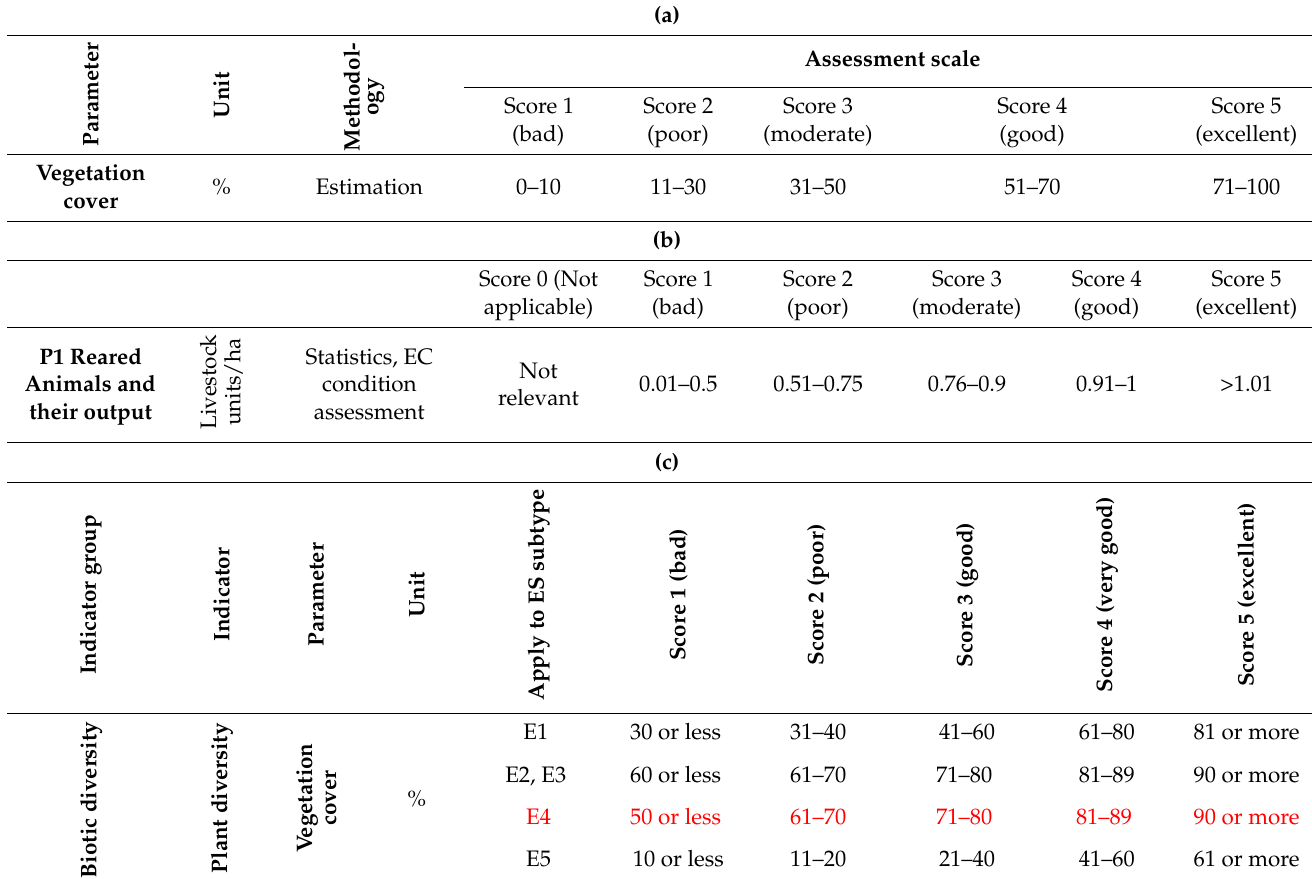
Table 1. Example of cross-ecosystem compatibility of parameter assessments—( a ) assessment scale for a grassland condition parameter; ( b ) assessment scale for grassland ecosystem services; and ( c ) adjustment of reference values for the same parameter after field verification with reference values determined by ecosystem subtype (red indicates subtype present in our study area). These reference values may be candidates for incorporating an update of the Methodological